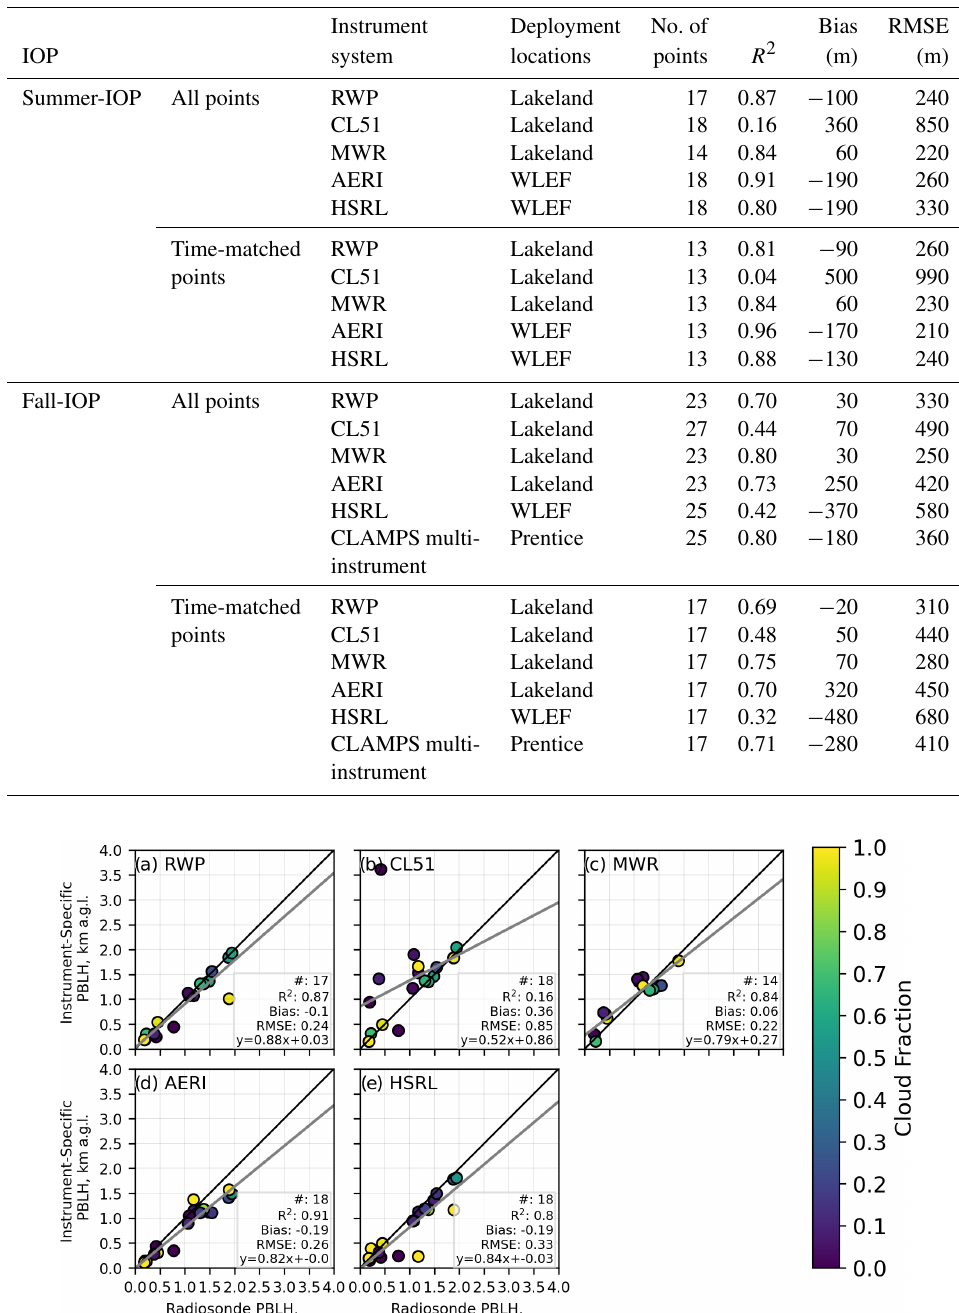
Table 4. Statistical comparison of PBLH estimated by the RWP, CL51, MWR, AERI, HSRL, and CLAMPS compared with the radiosonde- based PBLH estimates for both the Summer-IOP and Fall-IOP analysis. Results are presented for all available data points (upper portion of the section relative to each IOPs), and for the time-matched data points (bottom portion of the section relative to IOPs).